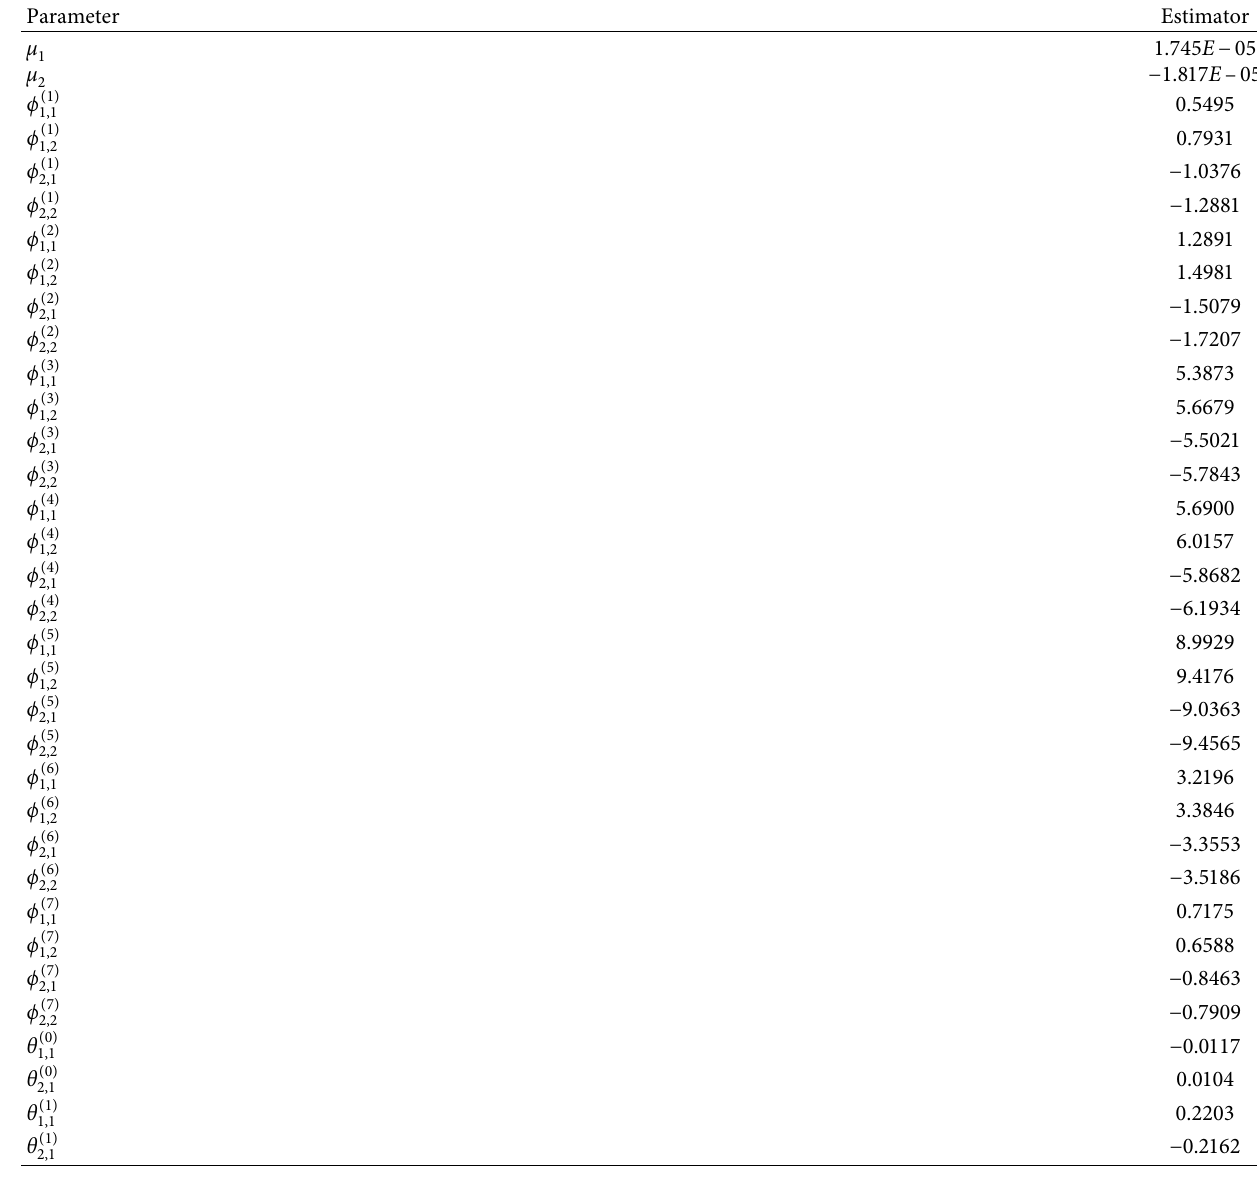
Table 6: Results of parameter estimates of VARX (7, 1).